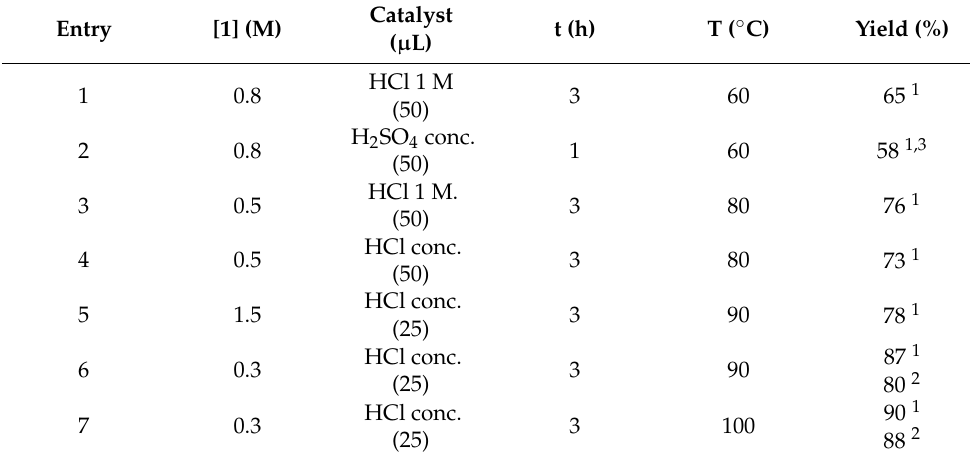
Table A1. Reaction conditions tested to obtain the molecule 3 .